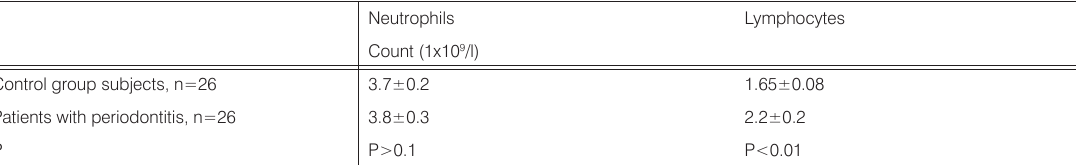
Table 2. Numbers of Neutrophils and Lymphocytes in Peripheral